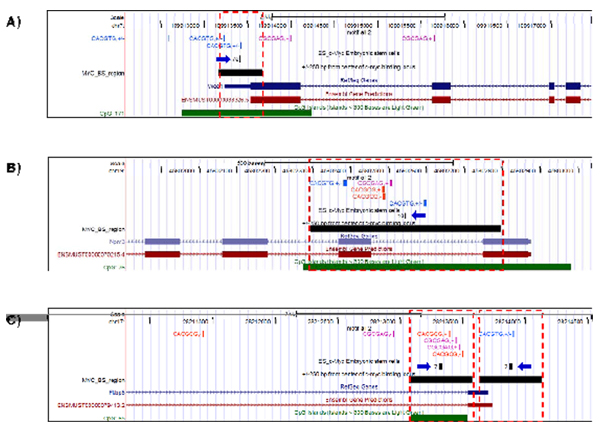
Multiple occurrence of c-Myc E-boxes in promoter region around transcription start site (TSS) of c-Myc target genes identified in ChIP-seq experiment. A: WEE 1 homolog 1(Wee1). The high-avidity (height peak = 76) c-Myc binding sites (pointed by blue arrow) in strong promoter region of Wee1 gene is supported with two canonical E-box CACGTG. The binding locus and E-boxes are overlapped with CpG Island which might be bound by c-Myc. B: Nucleoplasmin 3 (Npm3). The moderate-avidity (height peak = 10) as in the previous case the ChIP-seq c-Myc binding locus is located in the first intron promoter region. The locus is supported with five E-boxes: one canonical and three non-canonical E-boxes in first intron and another canonical E-box in second exon. In addition, this binding region and the E-boxes are located in CpG Island. C: FK506 binding protein 5 (Fkbp5). Two relatively low avidity c-Myc binding sites identified in ChIP-seq experiment confirmed with E-boxes. First ChIP-seq loci in upstream gene region has relatively low avidity biding site (height peak = 7) supported with canonical E-box CACGTG. The second ChIP-seq loci located in first intron and it is also relatively low avidity peak (height peak = 7) which is supported with two non-canonical E-boxes CACGCG and two non-canonical E-boxes CGCGAG. The last locus overlaps with CpG Island which suggests that this locus might be functional.